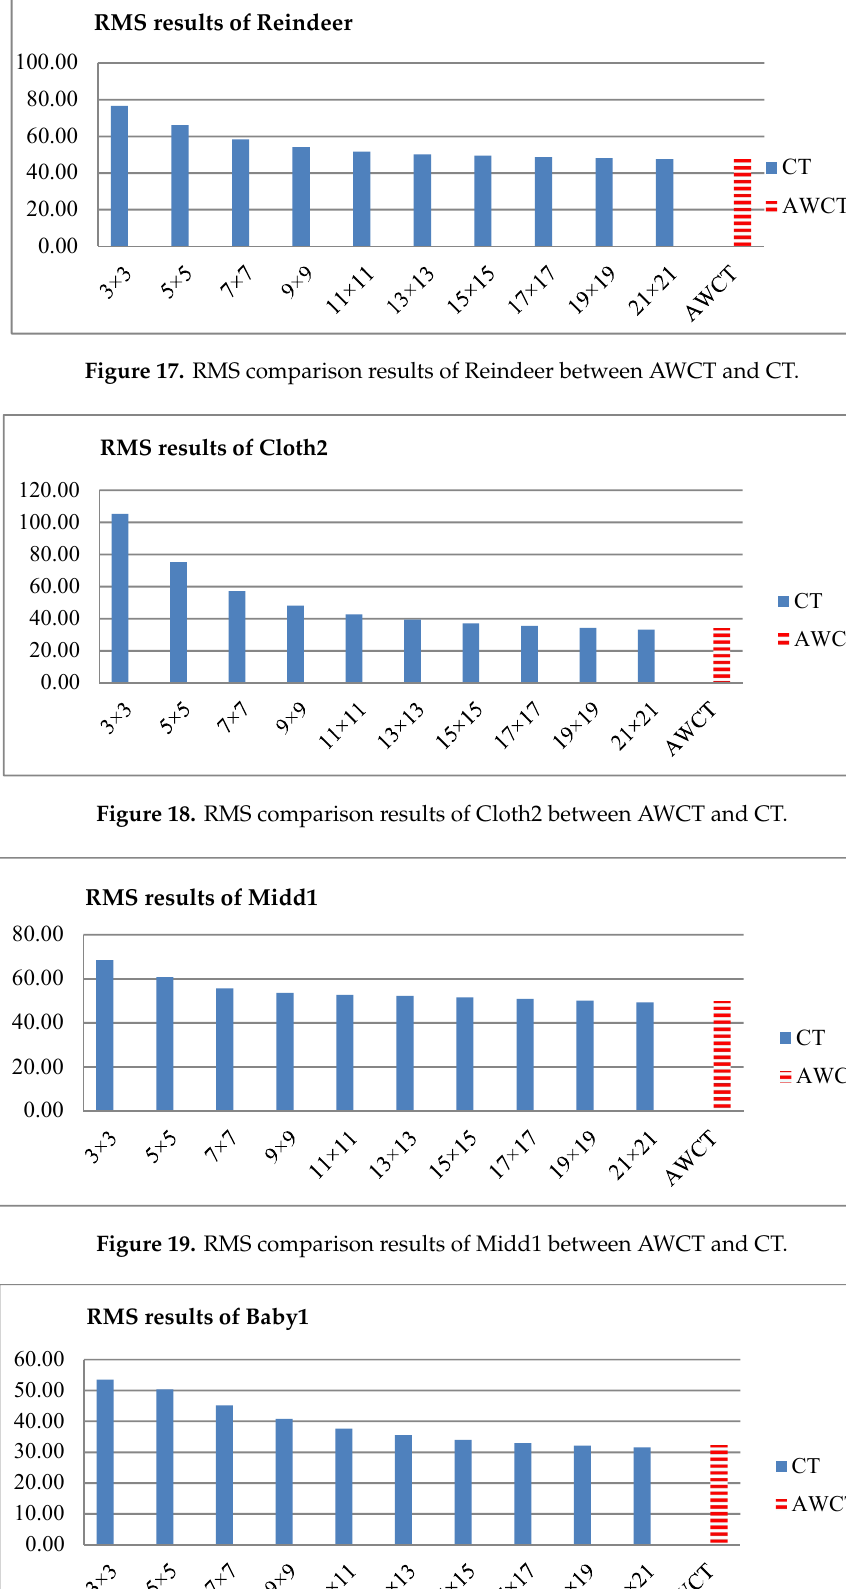
Figure 20. RMS comparison results of Baby1 between AWCT and CT.